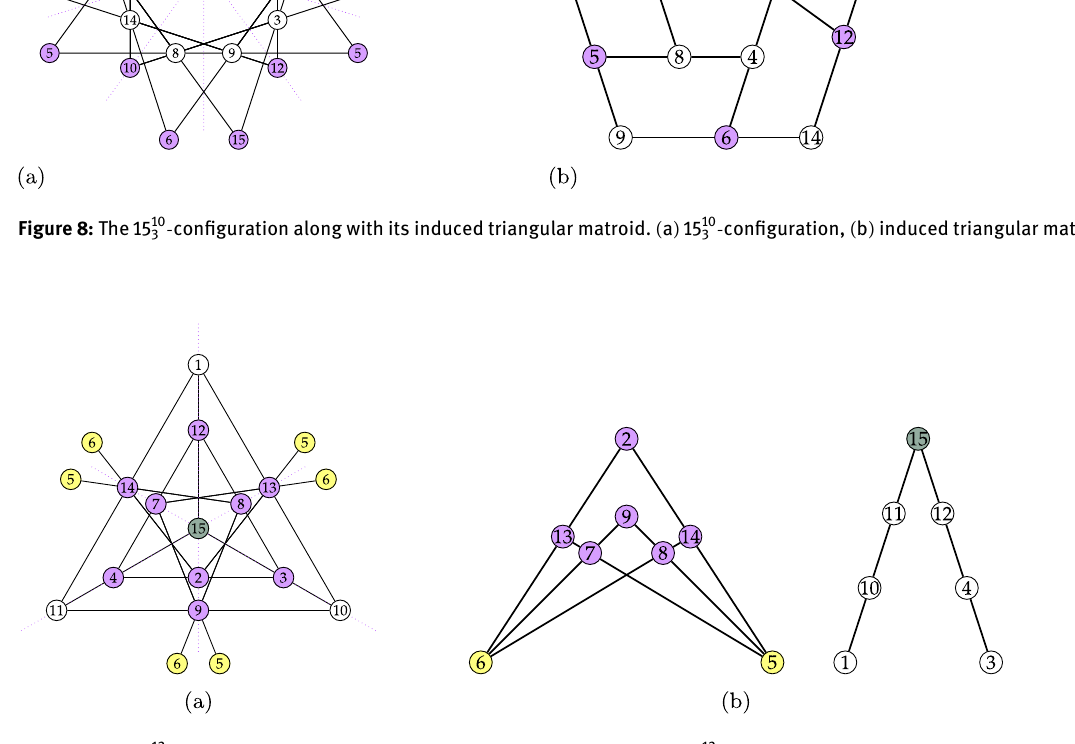
Figure 9: The 15 312 - con fi guration along with its induced triangular matroid. ( a ) 15 312 - con fi guration, ( b ) induced triangular